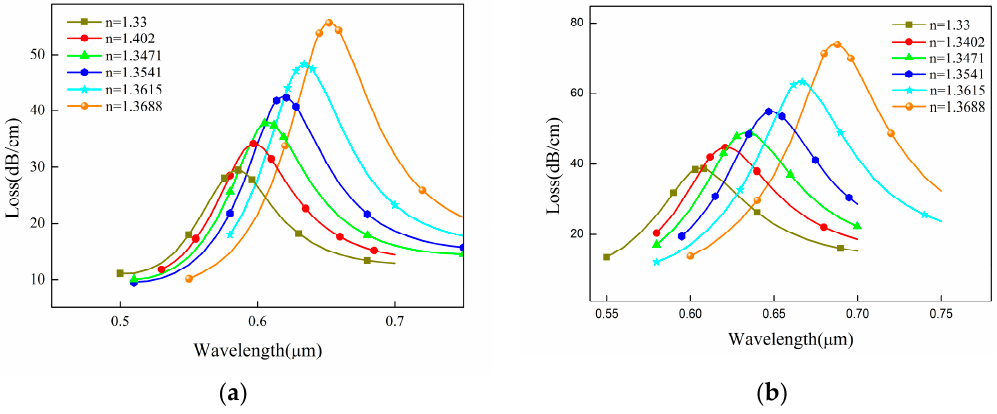
Figure 4. The comparison of the gold film with or without graphene coating. ( a ) Analysis of the confinement loss of PCF without graphene; ( b ) Analysis of the confinement loss of graphene-coated PCF.